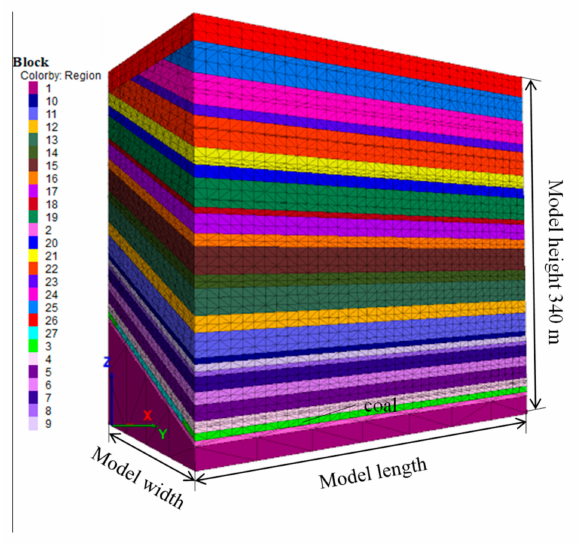
Figure 7. The numerical simulation model. Table 1. Mechanical parameters of the coal seam and its roof and floor.